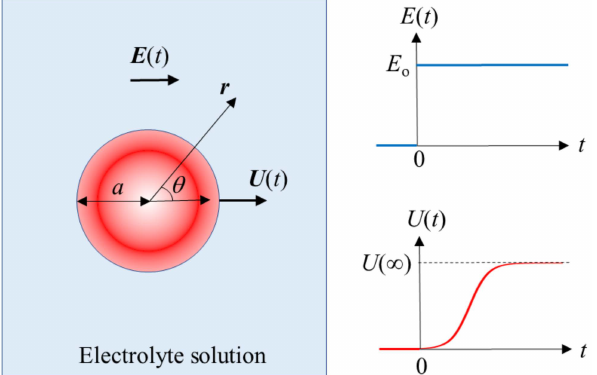
Figure 1. Spherical colloidal particle of radius a and zeta potential ζ moving with transient elec- trophoretic velocity U ( t ) in an electrolyte solution under an applied step electric field E ( t ). U ( ∞ ) is the magnitude of the static electrophoretic velocity at t = ∞